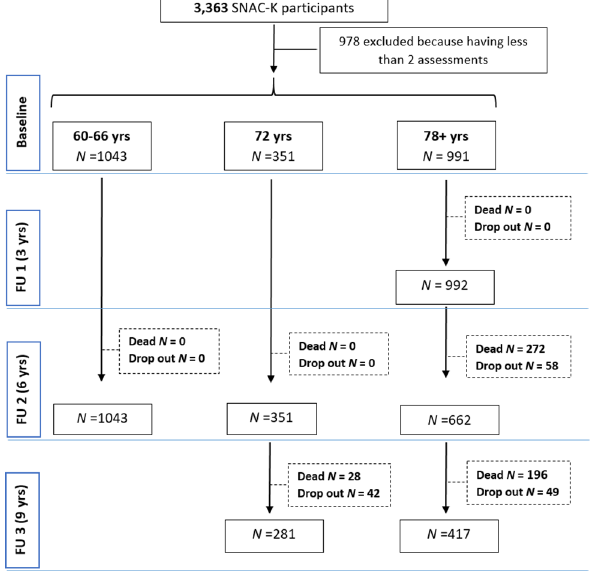
Fig 1. Flowchart of study participation over 9 years. Dropouts are due to either refusal of the participant/relative, loss of contact with the participant, or moving of the participant from the city where the study took place. FU1, follow- up 1; FU2, follow-up 2; FU3, follow-up 3; SNAC-K, Swedish National study of Aging and Care in